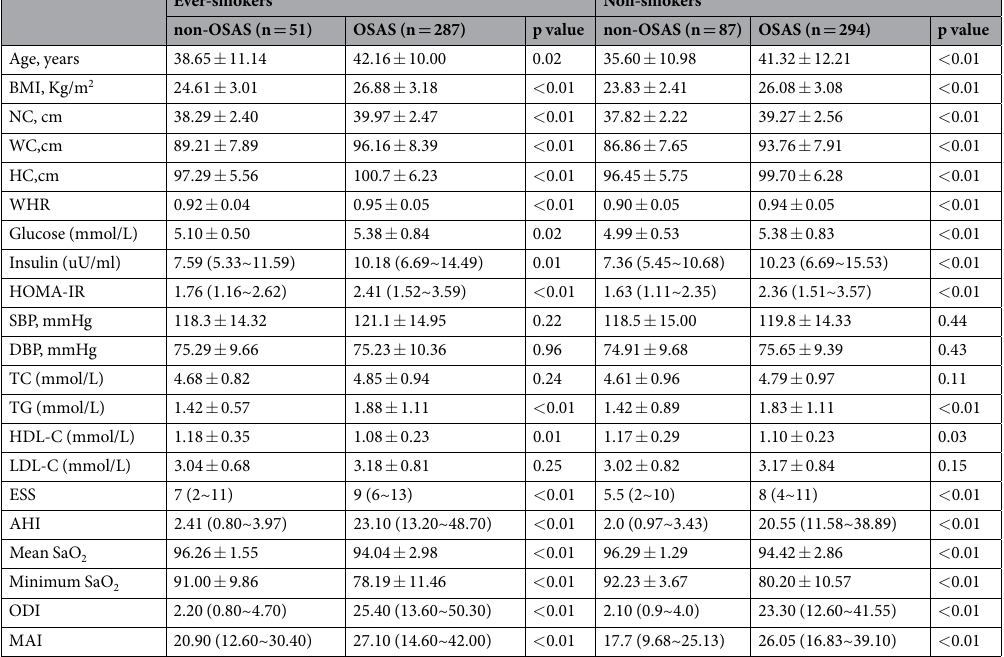
Table 1. Demographic and clinical characteristics of the enrolled subjects stratified by smoking status. Normally distributed data were presented as means ± standard deviation (SD), medians (interquartile range) and categorical data were presented as the number (percentage). Abbreviations: BMI, Body mass index; NC, neck circumference; WC, waist circumference, HC, hip circumference; HOMA-IR, homeostasis model of assessment for insulin resistence index; WHR, waist circumference/hip circumference ratio; SBP, systolic blood pressure; DBP, diastolic blood pressure; AHI, apnea-hypopnea index; SaO2, oxygen saturation; ODI, oxygen desaturation index; MAI, Micro-arousal index; ESS, Epworth sleepiness score; OSAS, obstructive sleep apnea syndrome; TC, total cholesterol; TG, triglyceride; HDL-C, high density lipoprotein cholesterol; LDL-C, low density lipoprotein